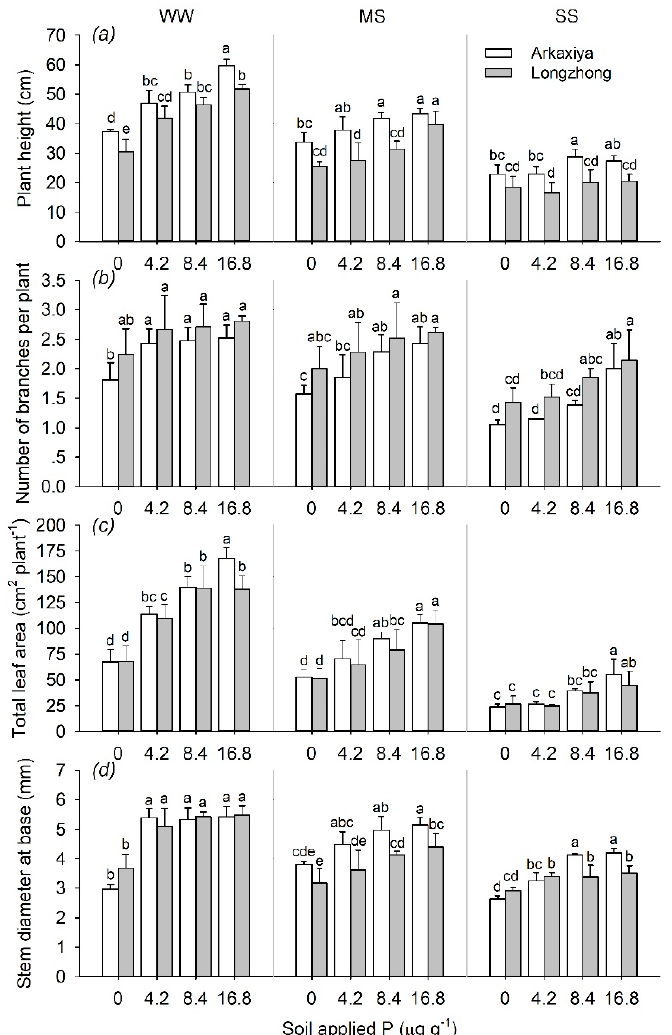
Figure 2. Changes in plant height ( a ), number of branches per pot ( b ), total leaf area ( c ) and stem diameter at base ( d ) of two alfalfa genotypes, Arkaxiya (white bars) and Longzhong (grey bars), grown for 10 weeks with four applied P levels and three water treatments: (i) well-watered (WW); (ii) moderate water shortage (MS); and (iii) severe water shortage (SS). Values are means + one standard error of the mean ( n = 3). Different letters between bars represent significant differences between means at p < 0.05.